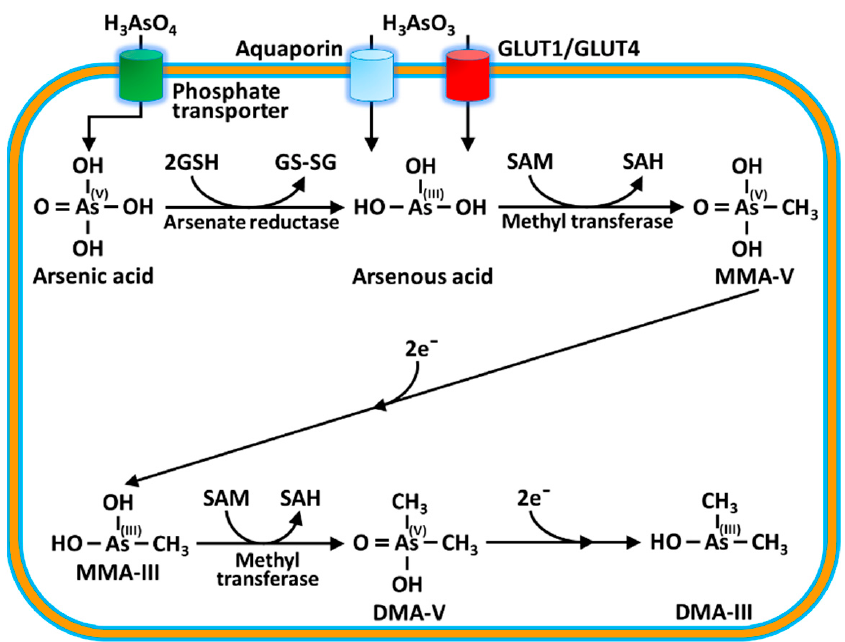
Figure 1. Metabolic pathways of arsenic. As (V) is reduced to As (III) by GSH (as electron donor) in the presence of arsenate reductase; As(III) undergoes sequential methylation with SAM (methyl donor) in the presence of methyl transferase and reduction with GSH to generate MMA(V), MMA(III), DMA(V) and DMA(III). GSH: reduced glutathione; GS-SG: oxidized glutathione; SAM: S-adenosyl methionine; SAH: S-adenosyl homocysteine; MMA(V): monomethyl arsenic acid; MMA(III): mono methyl arsenous acid; DMA(V): dimethyl arsenic acid; DMA(III): dimethyl arsenous acid). This figure is an elaboration based on information retrieved from ref. [54,55].